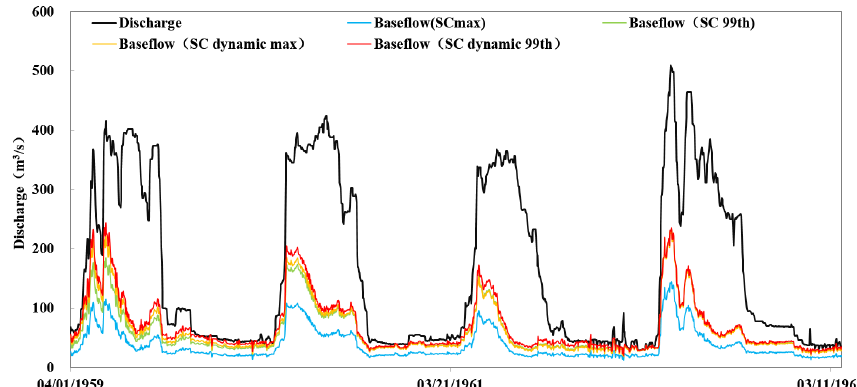
Figure 10. Comparison of baseflow calculation results of the main parameter determination methods for a site (07097000) in the Mississippi River